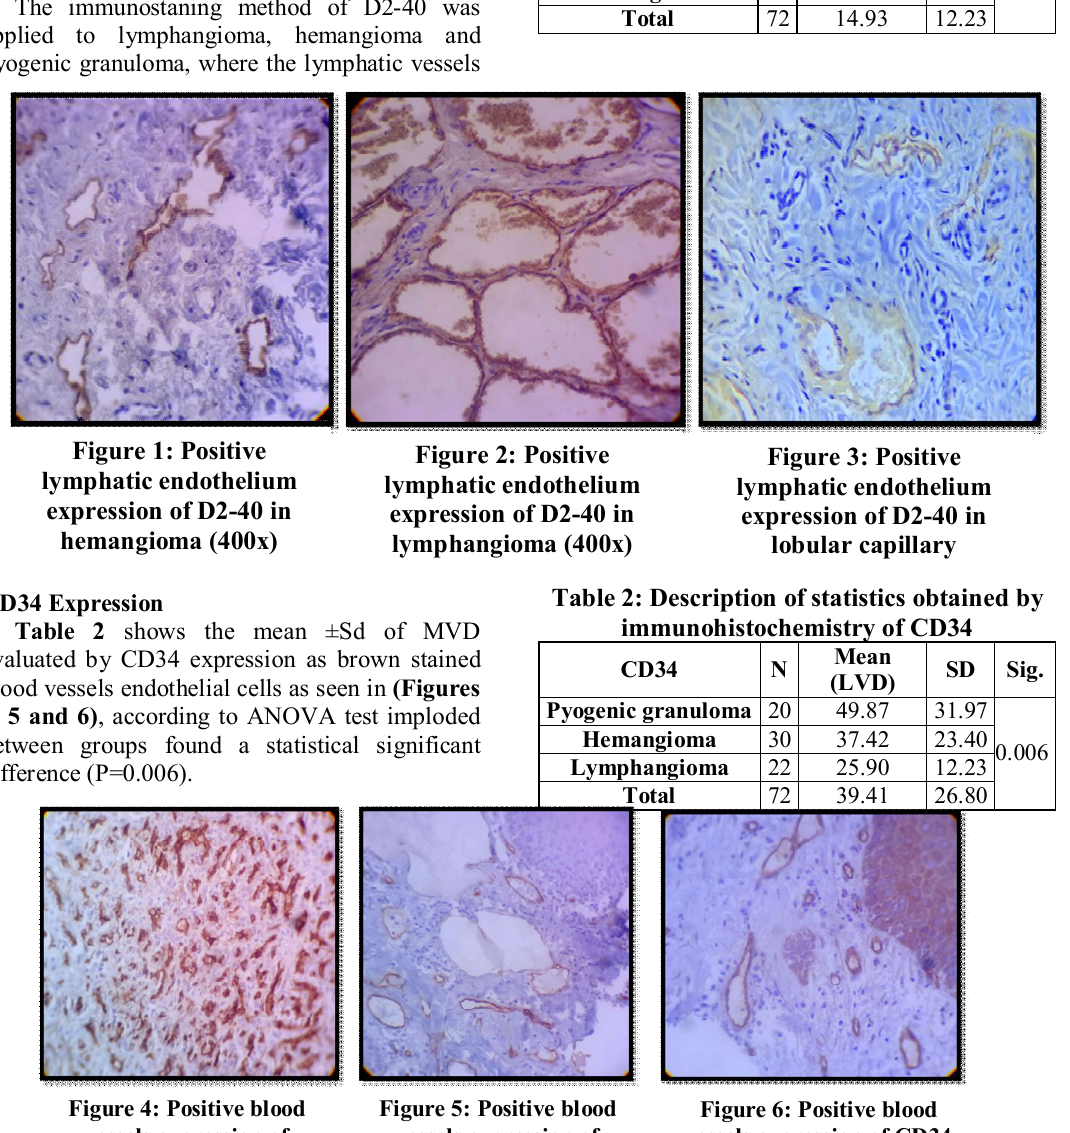
Figure 4: Positive blood Figure 5: Positive blood Figure 6: Positive